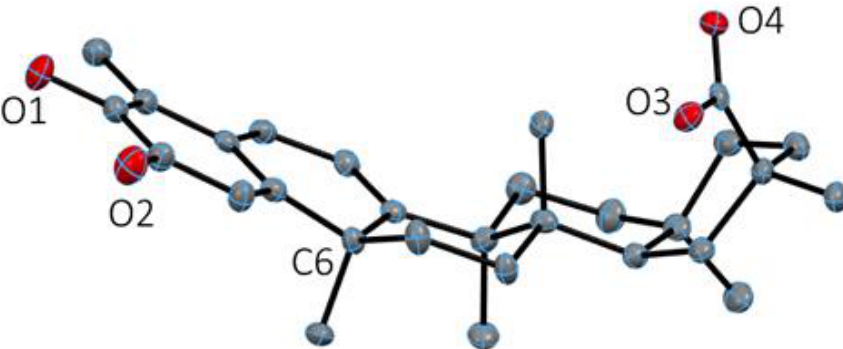
Figure 1. Three-dimensional packing of the dimeric celastrol molecules. The solvent chloroform molecule is not in the hole. H atoms not shown.